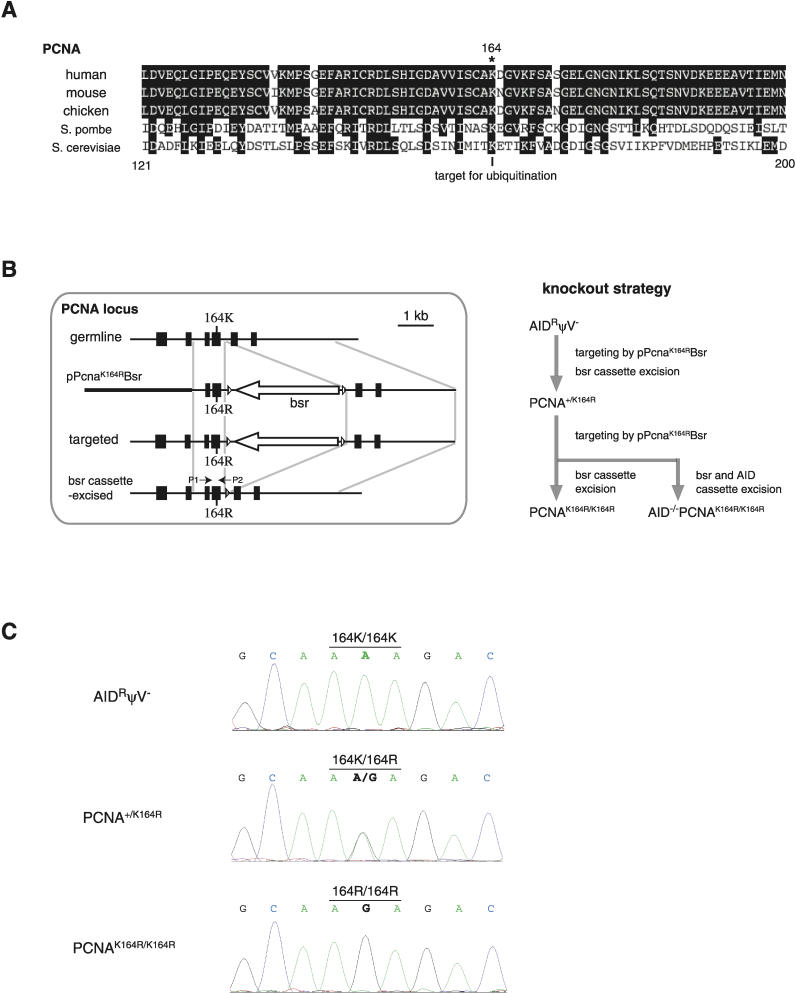
Site-Directed Mutagenesis of the PCNA Locus(A) Alignment of the human, mouse, chicken, Schizosaccharomyces pombe, and S. cerevisiae PCNA amino acid sequences. Amino acid 164 serving as the attachment site for ubiquitination in S. cerevisiae is marked by an asterisk.(B) A physical map of the PCNA locus and the PCNA mutagenesis construct, pPcnaK164RBsr. The targeting strategy of PCNA locus and the genealogy of the mutant clones are shown below and to the right, respectively.(C) Sequence chromatographs covering the PCNA codon 164 which was changed from AAA in the AIDRψV− clone to AGA in the PCNAK164R/K164R clone.